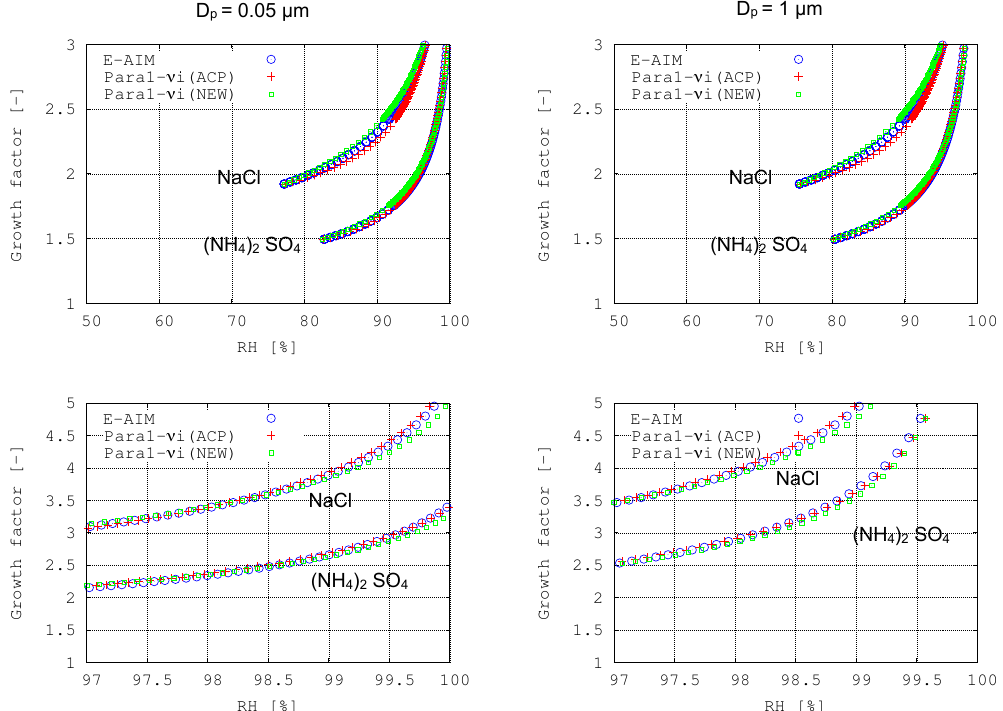
Figure B1. Growth factor of pure NaCl (cr) and ( NH 4 ) 2 SO 4 ( cr ) particles with a dry diameter D s = 0 . 05 [ µm ] (UL) and D s = 1 [ µm ] (UR) for RH ≤ 97 [ % ] . Lower panels show the corresponding values within the subsaturated regime, i.e. 97 ≤ RH ≤ 100 [ % ] . The results of the parameterisation used by EQSAM4clim (labelled NEW) are compared to our ACP(M2012) water activity, a w -parameterisation (labelled ACP, i.e. Para1 of Table 1 in M2012). The comparison includes the results of E-AIM and extends the corresponding figures of M2012.